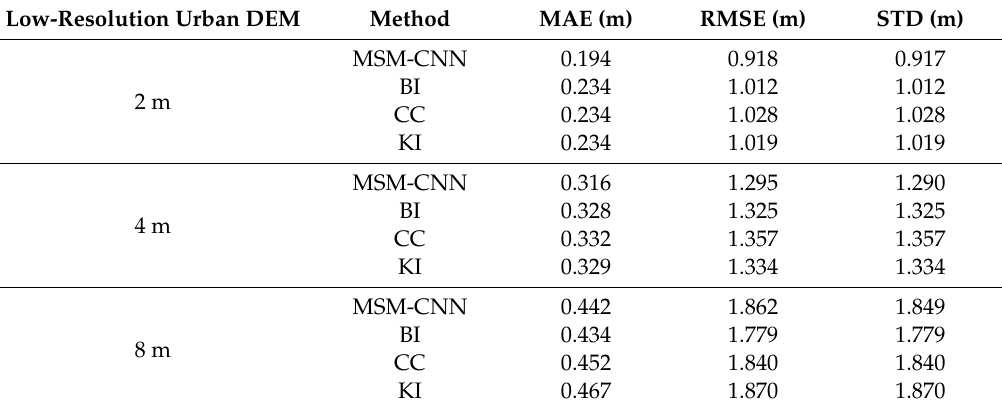
Table 1. Accuracy statistics in the whole reconstructing